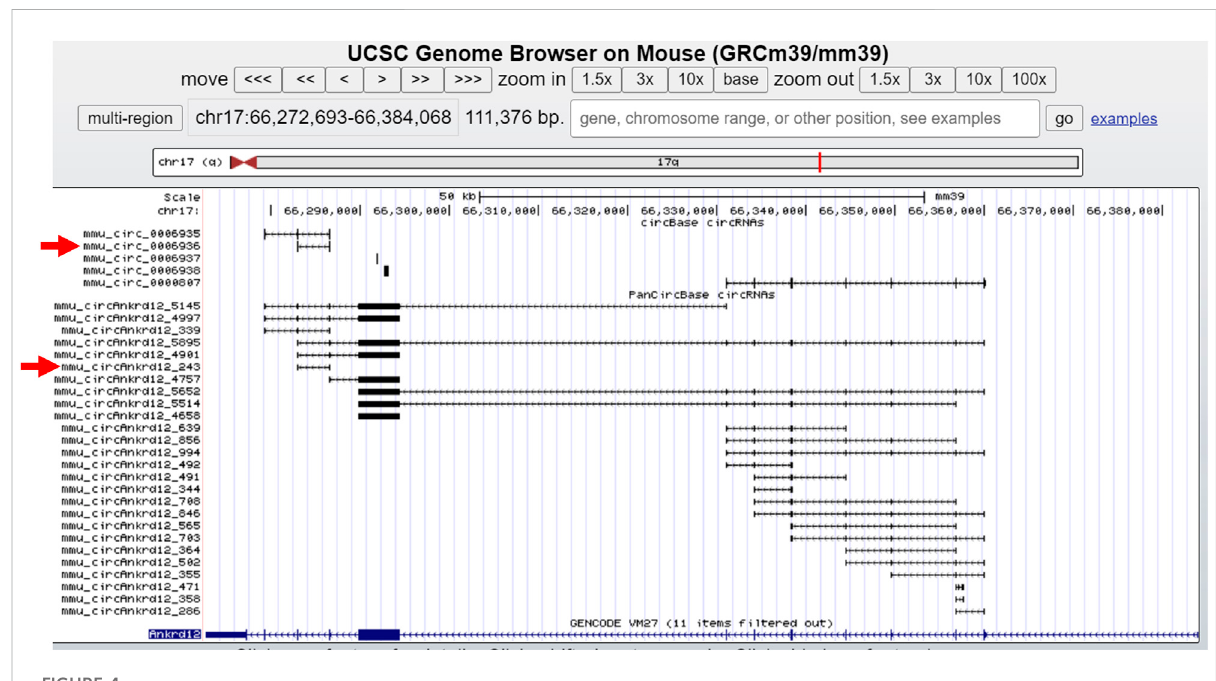
FIGURE 4 Overview of circRNAs generated from Ankrd12 in UCSC genome browser. The red arrow indicates the mmu_circAnkrd12_243 and the corresponding circBase